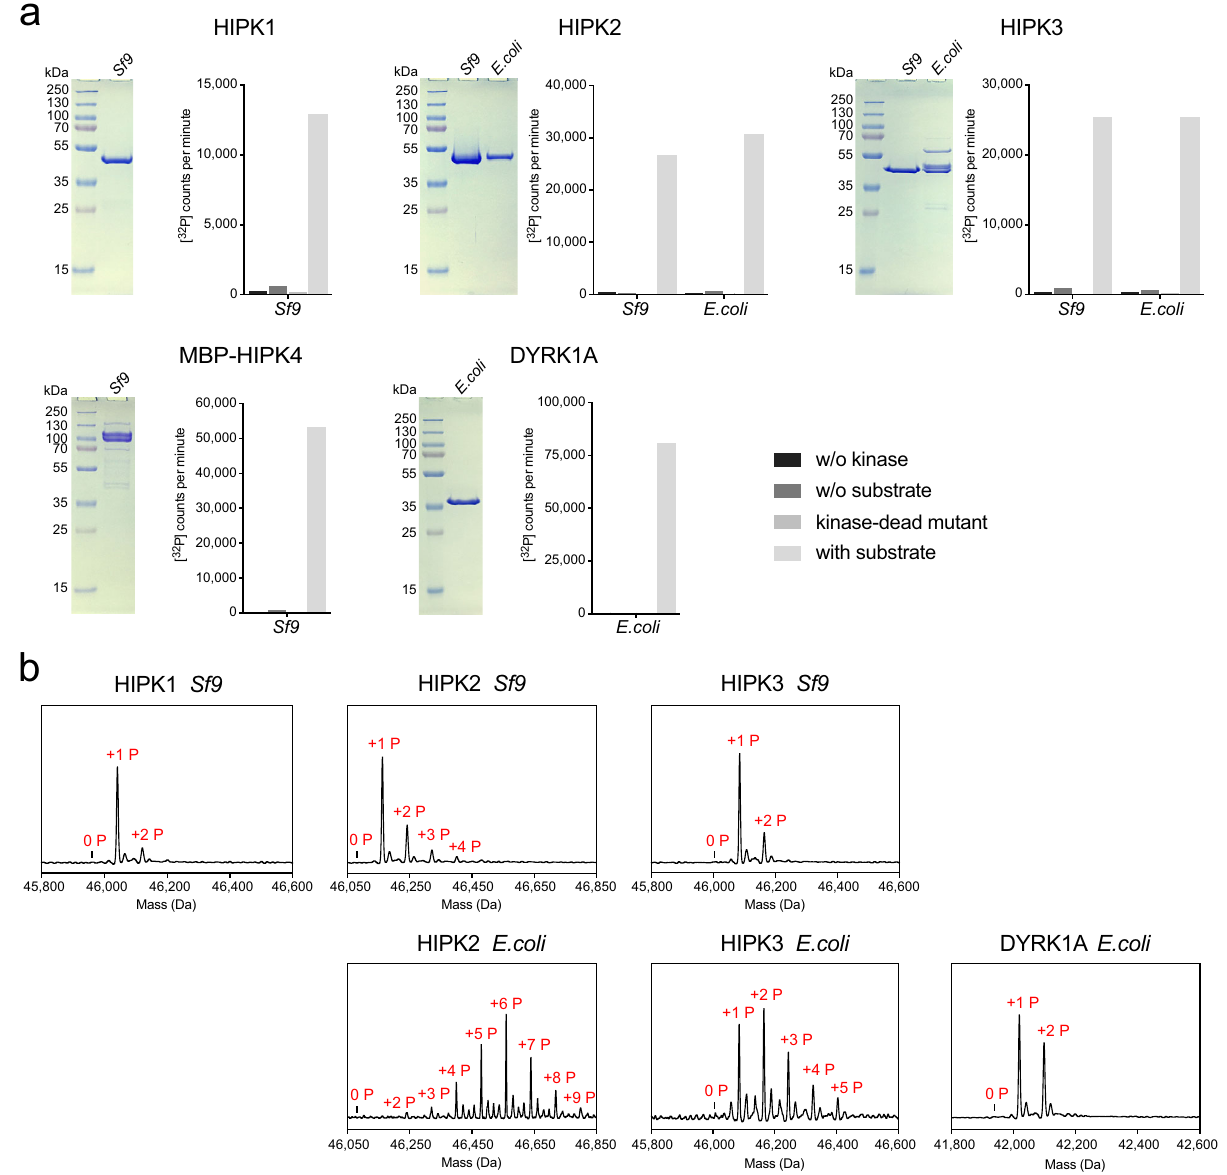
Fig. 4 Activity and phosphorylation status of recombinant HIP kinases. a Puri fi cation and activity measurements for all four HIPKs and DYRK1A. Recombinant protein kinases were either puri fi ed from Sf9 insect cells or from E. coli bacterial cells and analyzed by SDS-PAGE. Kinase activity was assessed using in vitro kinase assays with 0.2 mM [ 32 P]- γ -ATP, which was incubated for 30 min either without kinase, without substrate, as a kinase-dead mutation (HIPK1 D315N , HIPK2 D324N , HIPK3 D322N , and HIPK4 D136N ) or as wild-type kinase in the presence of 0.2 μ M kinase and 10 μ M His-c-Myc as a substrate. Measurements were performed as duplicates ( n = 2 biologically independent samples) and are depicted as mean. b Molecular masses of intact kinases determined by ESI – (LC) – MS indicate the total number of phosphorylations. Source data are provided as a Source Data fi